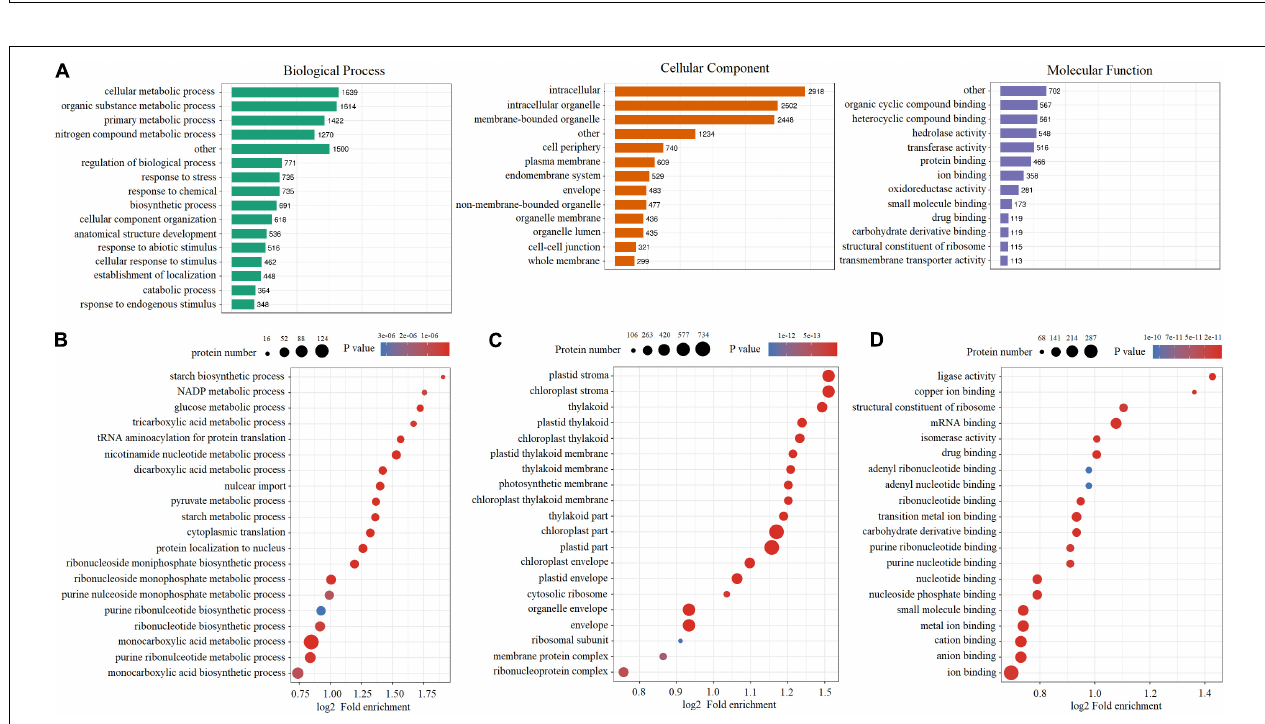
FIGURE 3 | Gene Ontology analysis of quantified and differentially expressed proteins under cold stress. (A) GO annotation of quantified and differentially expressed proteins. (B) GO enrichment analysis in the biological process. (C) GO enrichment analysis in the cellular component. (D) GO enrichment analysis in the molecular